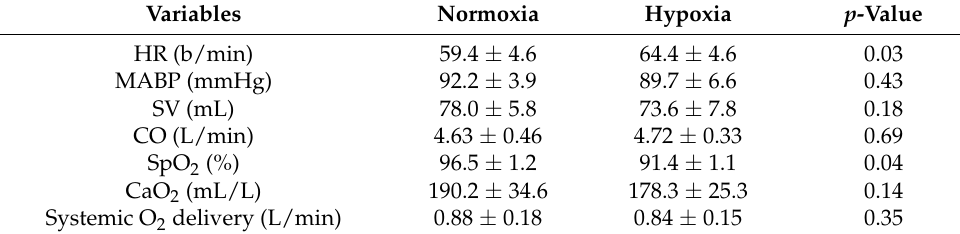
Table 2. Resting (sitting on the cycle ergometer) values of the normoxia and hypoxia sessions.